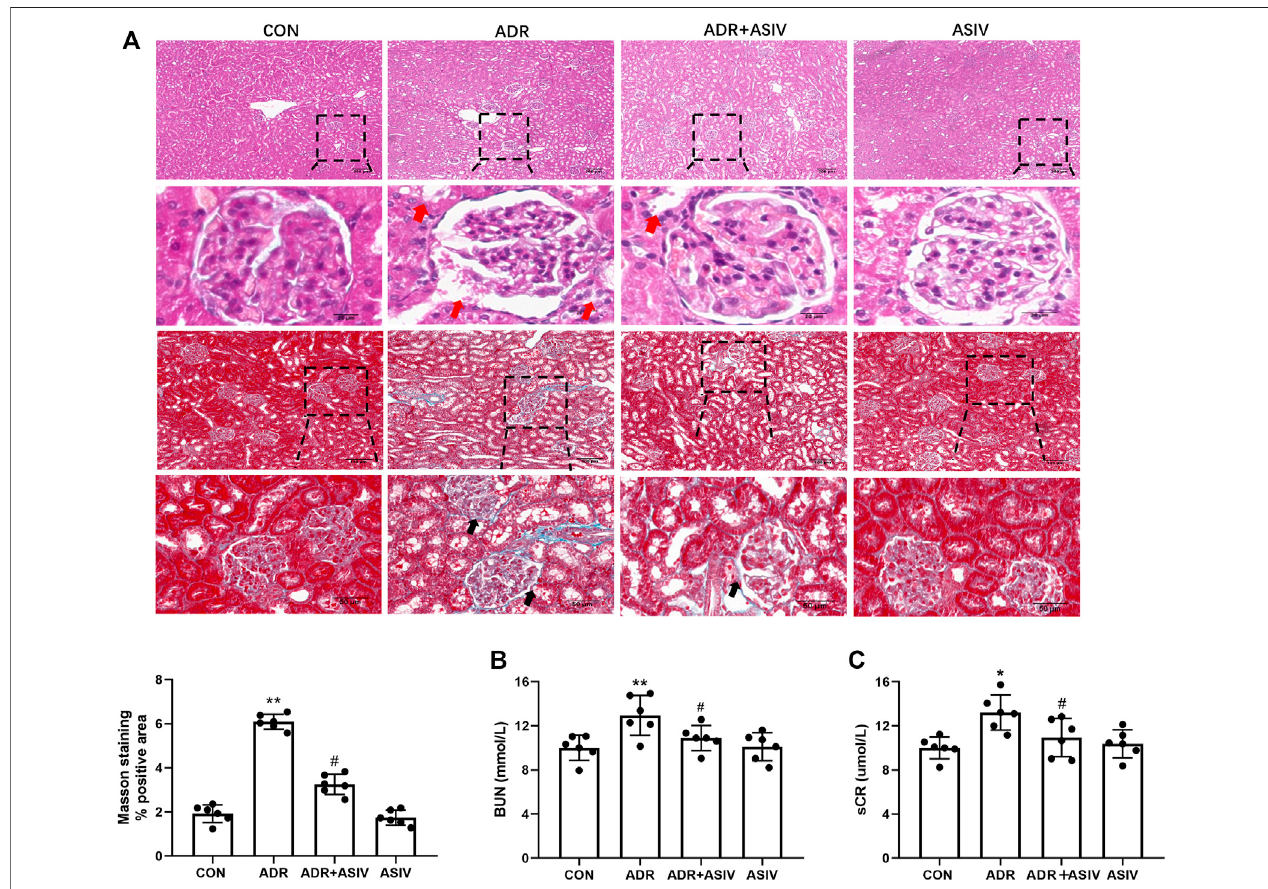
FIGURE 1 | ASIV attenuates ADR-induced functional and structural renal damage. (A) Representative images of H&E and Masson staining of rat renal section in eachgroupandquanti fi cationof fi brosis.Redarrowsindicatedatrophyofglomerulusandtubularlumendilatation;blackarrowsindicatedperiglomerular fi brosis. (B) The levels of blood urea nitrogen (BUN) and (C) serum creatinine; data were expressed as mean ± SD, n = 6. * p < 0.05, ** p < 0.01 vs. CON group. # p < 0.05, ## p < 0.01 vs. ADR group.